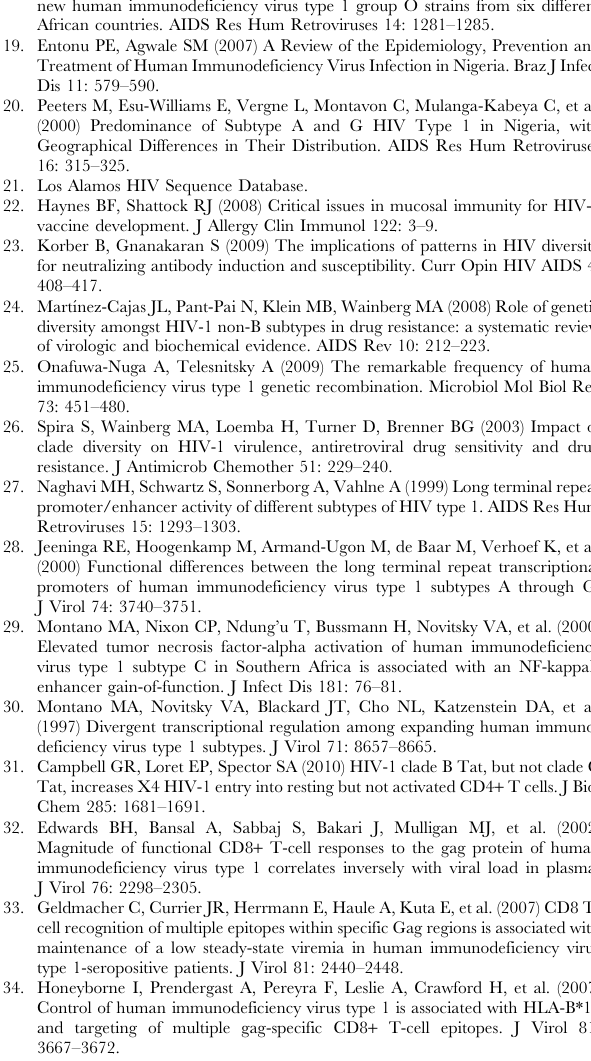
Table S3 Evolutionary rate and parameters estimated from